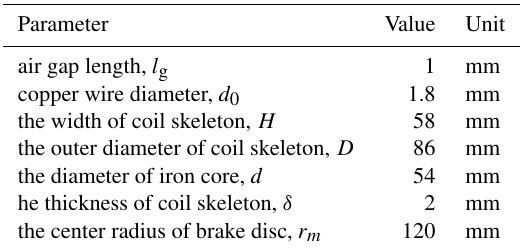
Figure 6. Braking torque curves of theoretical calculations and ex- periments. Table 1. Structural parameters of electromagnetic